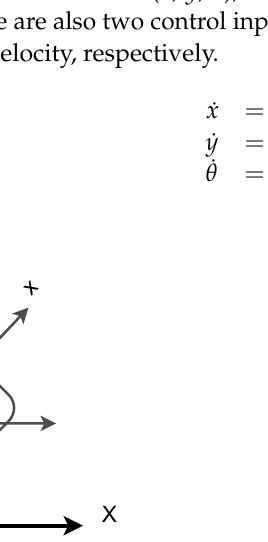
Figure 1. Kinematic model of non-holonomic